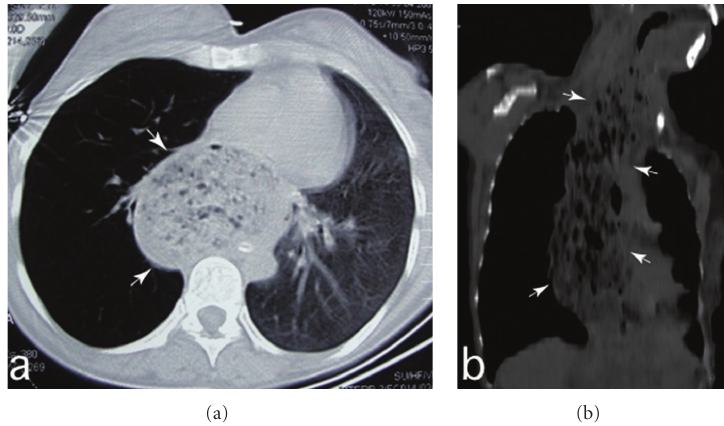
Figure 1: Thoracic computed tomography examination after intubation. (a) The axial cross-section shows a severely dilated oesophagus filled with food residue behind the trachea (arrows). The left lung parenchyma was infiltrative due to aspiration, and the heart was compressed by the dilated esophagus. (b) The coronal cross-section shows that the oesophagus is filled with food and air up to the cervical region (arrows).